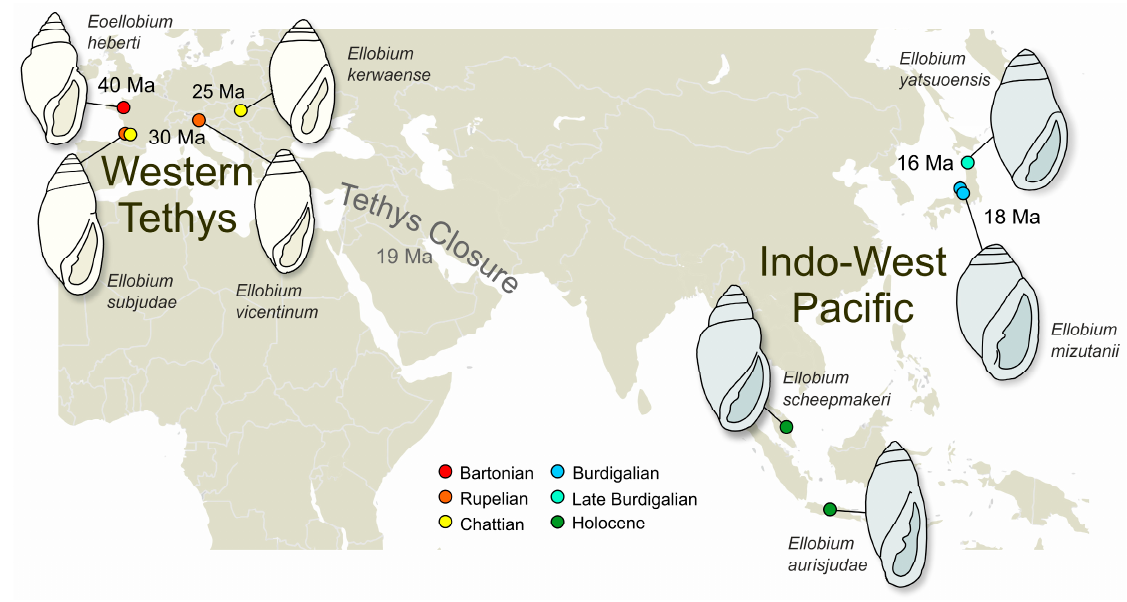
Figure 5. Middle Eocene to Holocene geographic and stratigraphic distribution of Eoellobium and Ellobium .